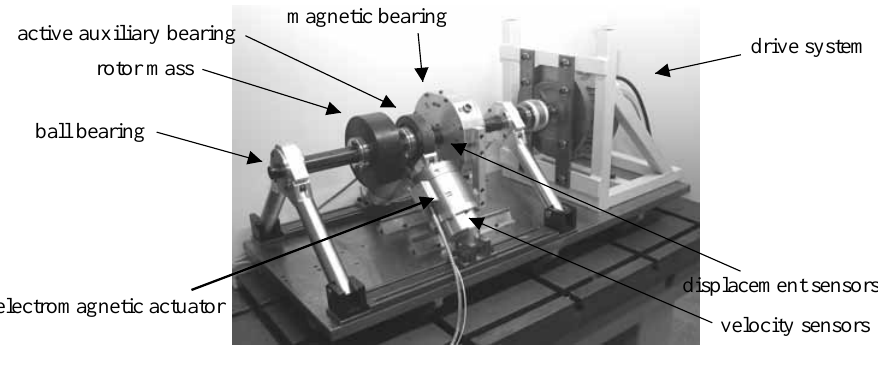
Fig. 14. Test rig at TU